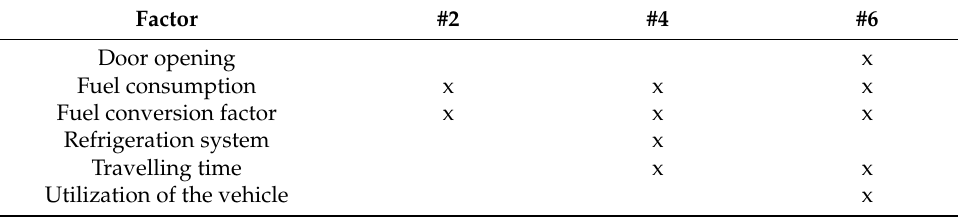
Utilization of the